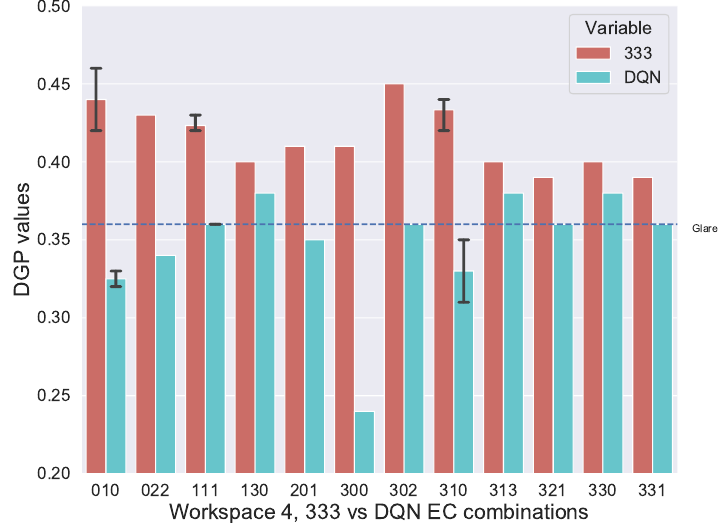
Figure 16. Workspace 4 : Comparison of 333 (dark) combination with DQN proposed